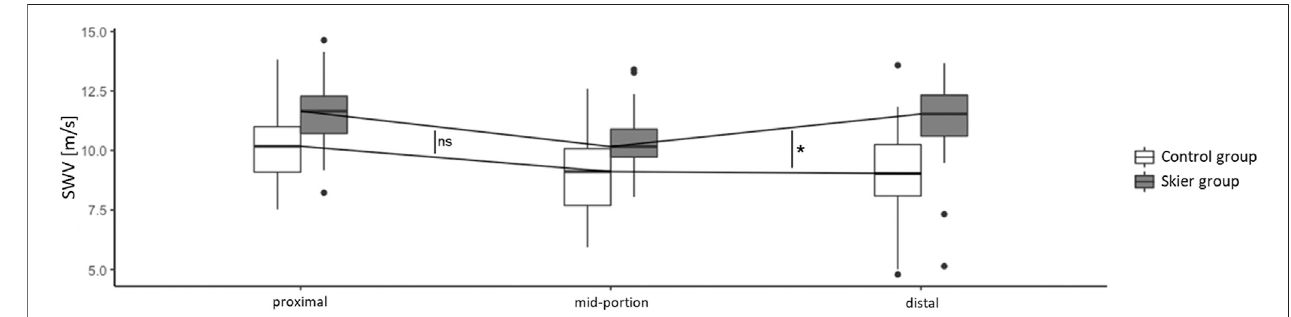
FIGURE 3 | Regional shear wave velocity in both study groups. Box: Median, interquartile range, range and